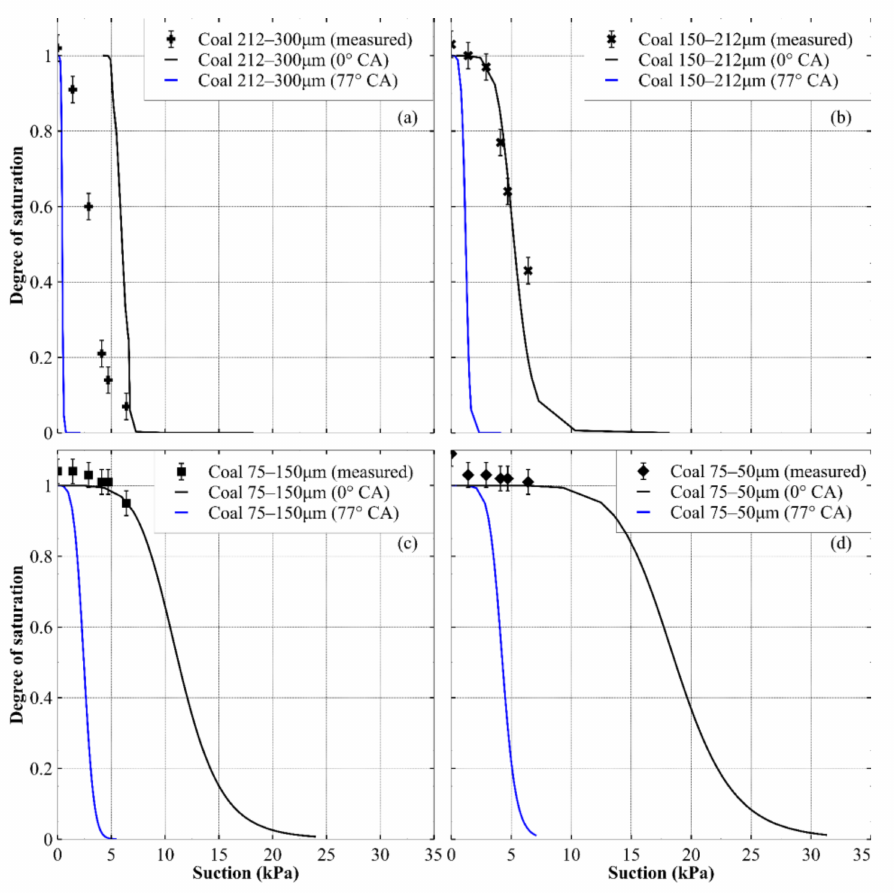
Figure 12. Predicted drying paths of the WRCs for crushed coal at different contact angles: ( a ) 212–300 µ m size fraction; ( b ) 150–212 µ m size fraction; ( c ) 75–150 µ m size fraction and ( d ) 50–75 µ m size fraction. For each prediction, CA values of 0 (black lines) and CA mean − CA SD (blue lines) were